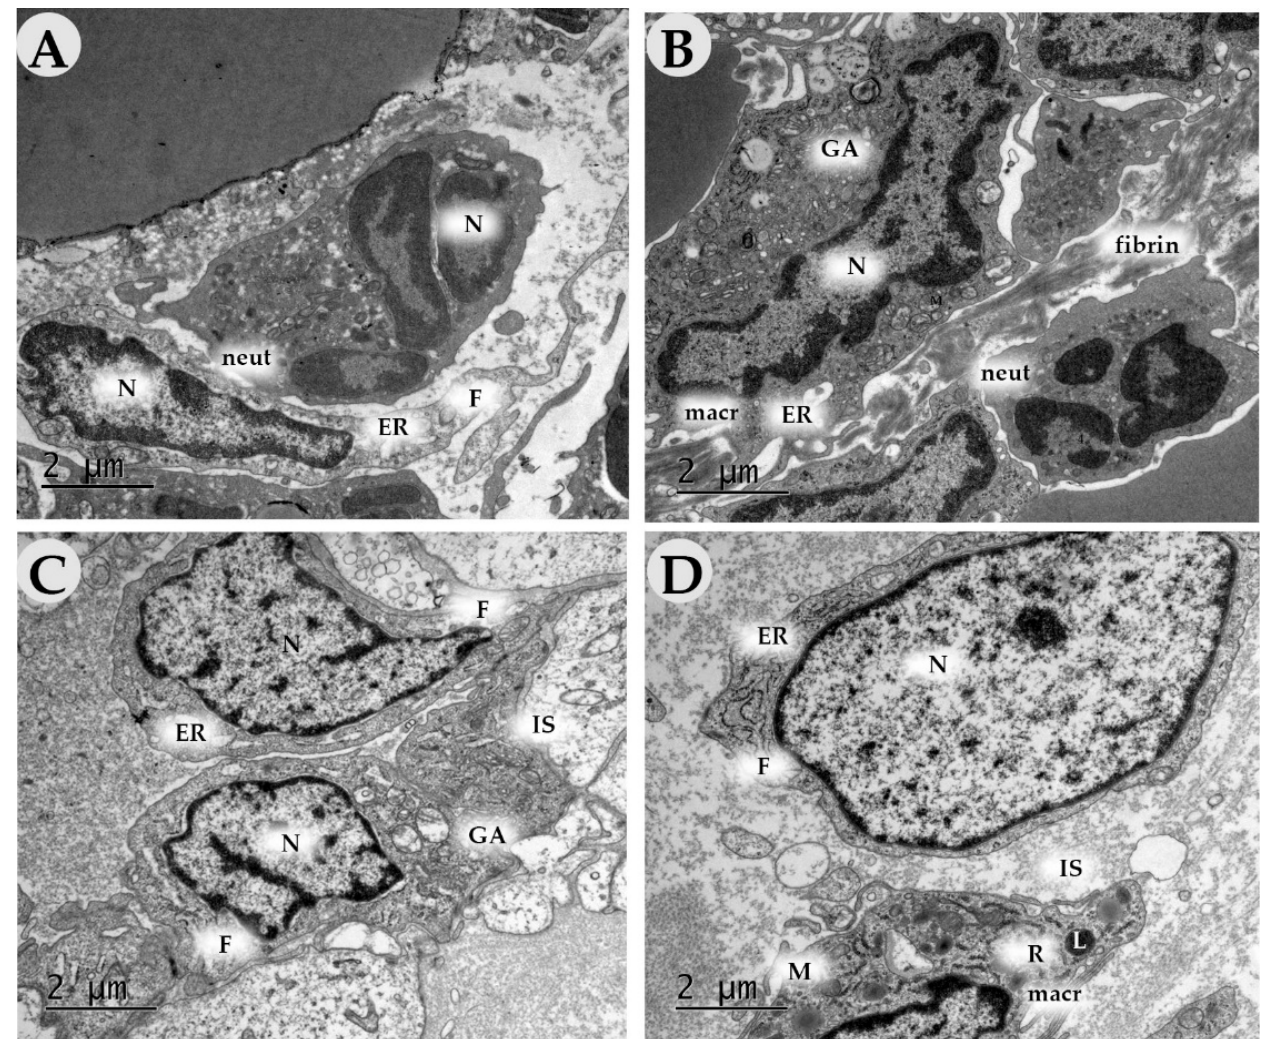
Figure 16. Transmission electron microscopy of the wound bottom of animals in the control (air ( A ), saline ( B )) and experimental groups (NO-CGF ( C ), DNIC ( D )) on day 3. Magnification × 15,000. neut—neutrophil, F—fibroblast, macr—macrophage, N—nucleus, M—mitochondria, GA—Golgi apparatus, L—lysosome, R—ribosome, ER—endoplasmic reticulum, IS—intermediate substance.